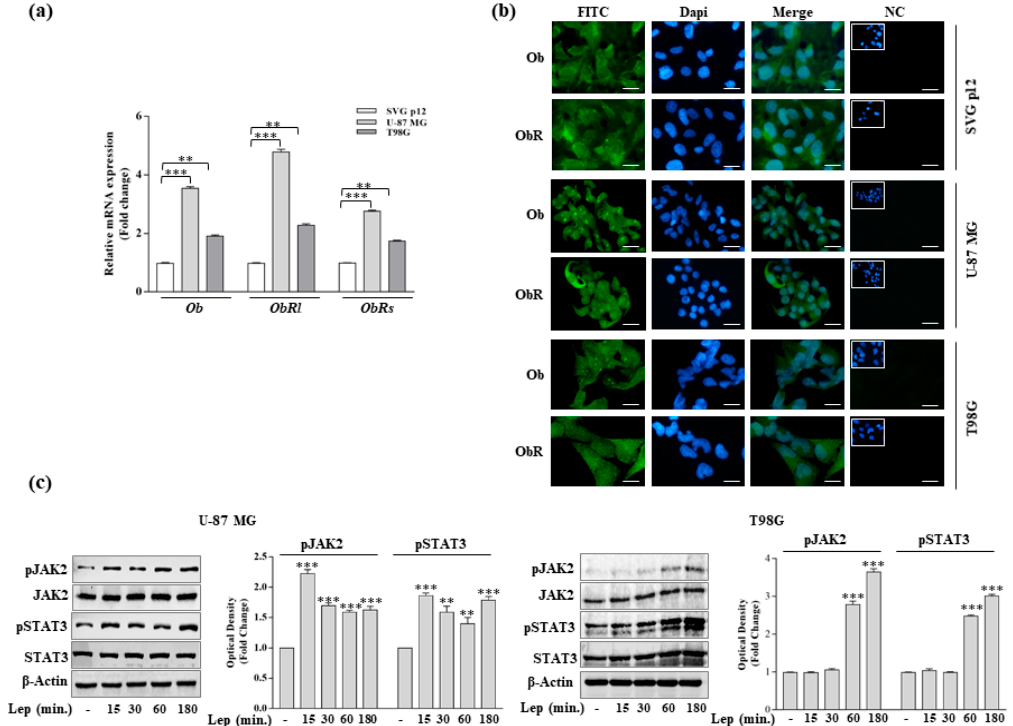
Figure 1. Leptin and leptin receptor expression and signaling activation in GBM cells. ( a ) Real ‐ time RT ‐ PCR for Ob and ObR long and short isoforms ( ObRl and ObRs, respectively) in U ‐ 87 MG and T98G cells; mRNA expression is shown relative to SVG p12 normal human glial cells. ( b ) Immunofluorescence of Ob and ObR in U ‐ 87 MG, T98G, and SVG p12 cells. DAPI staining for nuclear detection. Scale bars = 5 μ m. Original magnification, ×100. FITC, fluorescein isothiocyanate; NC, negative control. ( c ) Levels of phosphorylated (p) JAK2 and (p) STAT3 and relative total proteins evaluated by immunoblotting in total extracts from cells treated with vehicle ( ‐ ) or Leptin (Lep, 500 ng/mL) as indicated. β‐ Actin was used as a loading control. The histograms represent the means ± SD of three separate experiments in which band intensities were evaluated in terms of optical density arbitrary units and expressed as a fold change in phospho ‐ proteins/total proteins/ β‐ Actin vs. vehicle ‐ treated samples, which were assumed to be 1. ** p < 0.01, and *** p < 0.001.